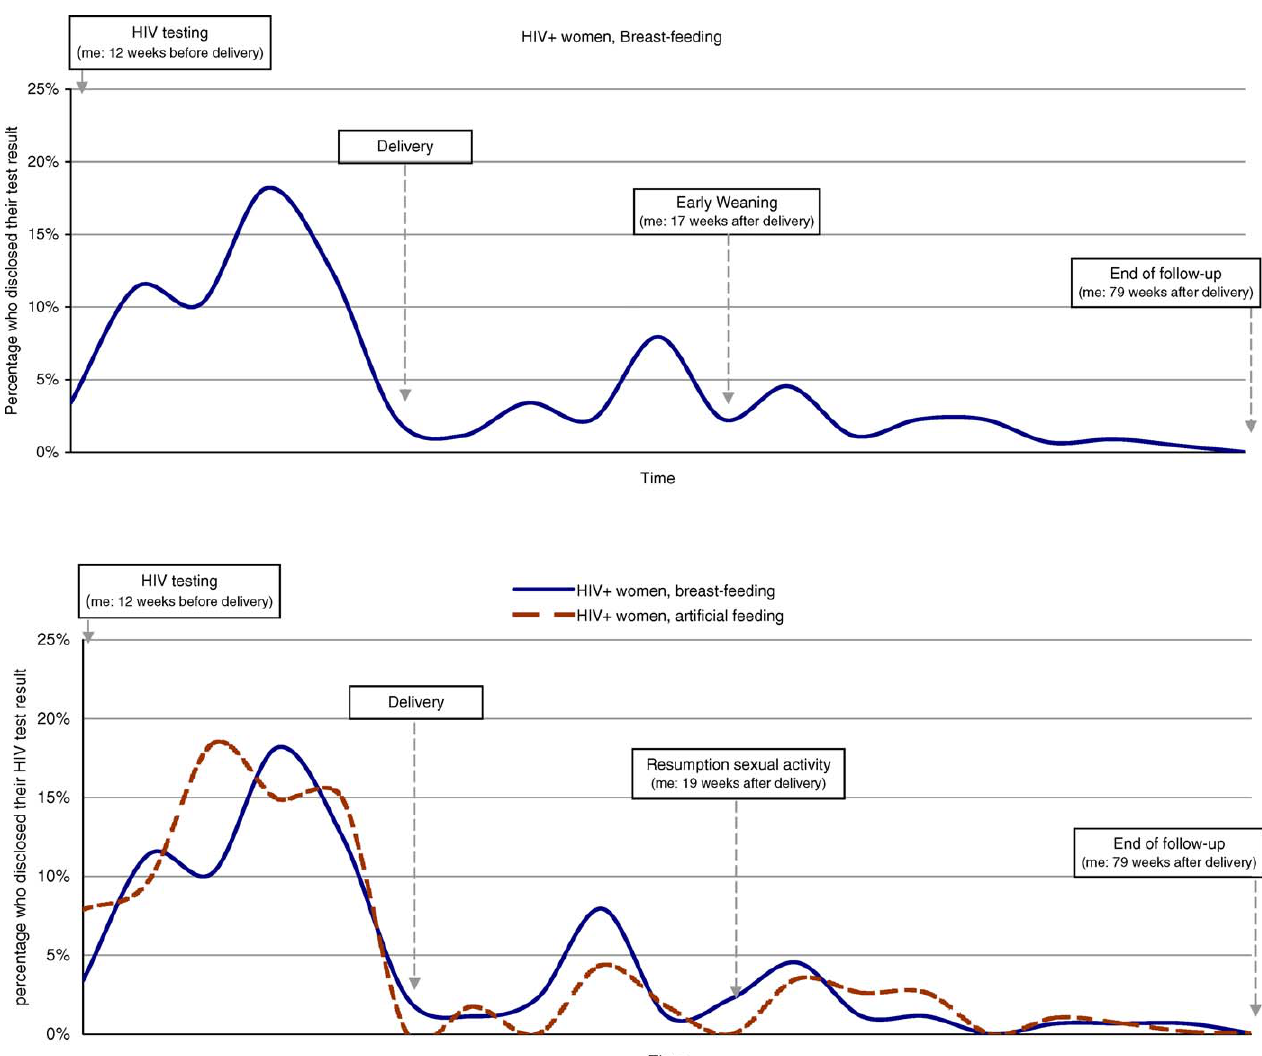
Figure 1. Distribution of the Moment when HIV-Infected Women Disclosed Their Status to Their Male Partner between HIV Testing and the End of Follow-Up (Ditrame Plus ANRS 1201-1202-1253, Abidjan, 2001–2005) (A) In relation to delivery and weaning. (B) In relation to delivery and resumption of sexual activity. See Text S1 for details on the construction of the curves. me, median.